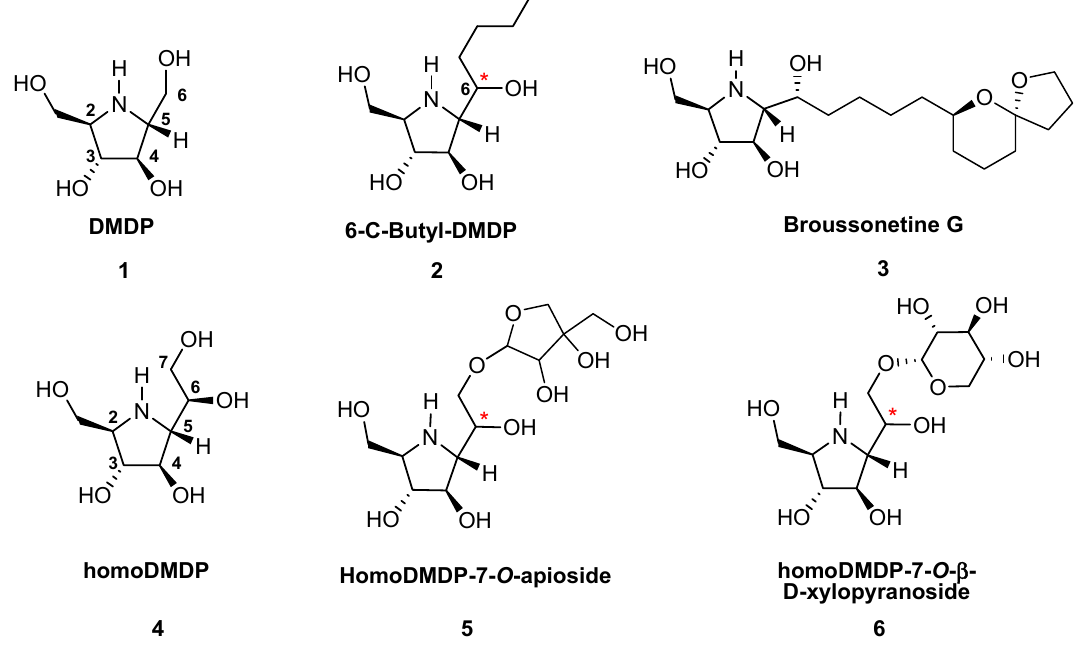
Figure 1. DMDP, homoDMDP and 6- C -alkyl-DMDP natural products.